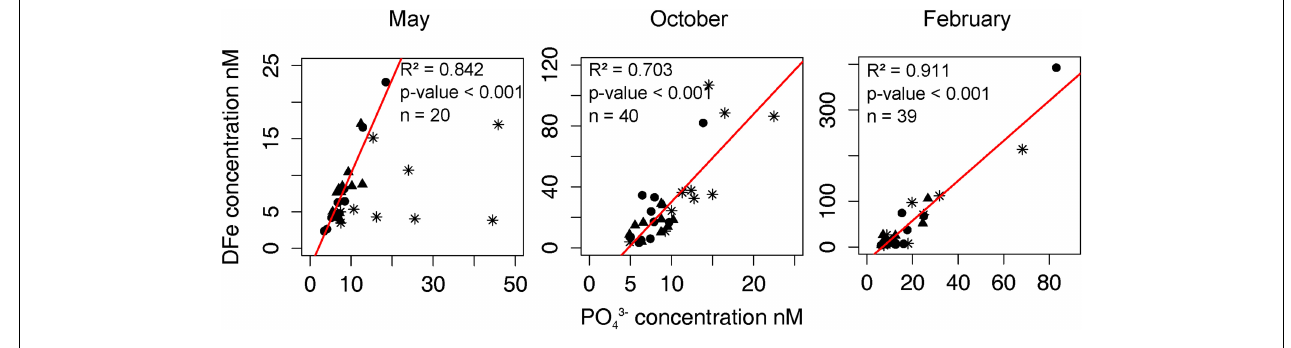
FIGURE 5 | Linear regression (red line) between the phosphate concentration [PO 3 − 4 ] and the concentration of dissolved iron [DFe] in May, October, and February (DFe data from Bressac and